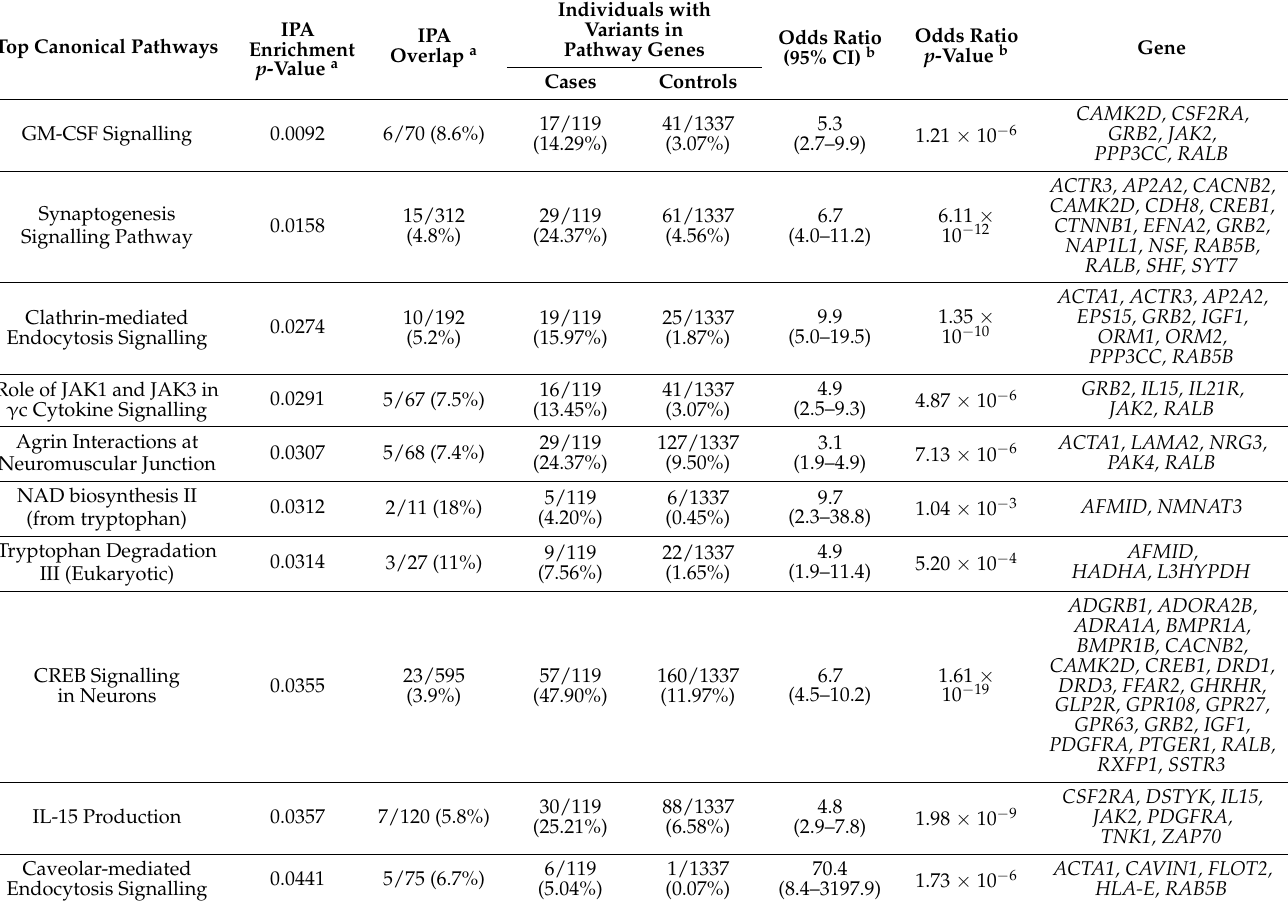
Table 5. Top 10 canonical pathways identified by IPA Pathway